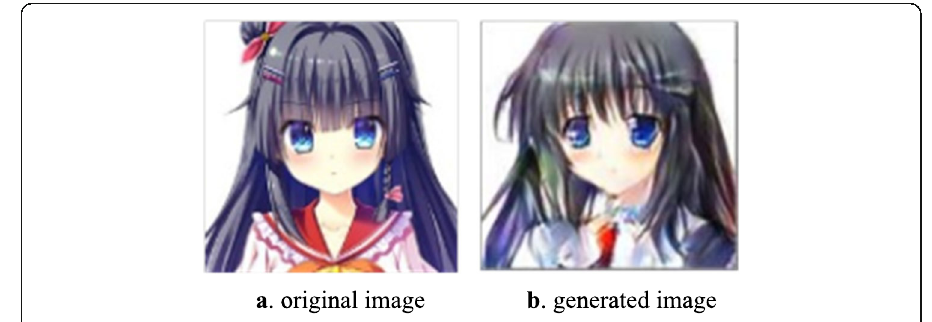
Fig. 6 a Original image. b Generated